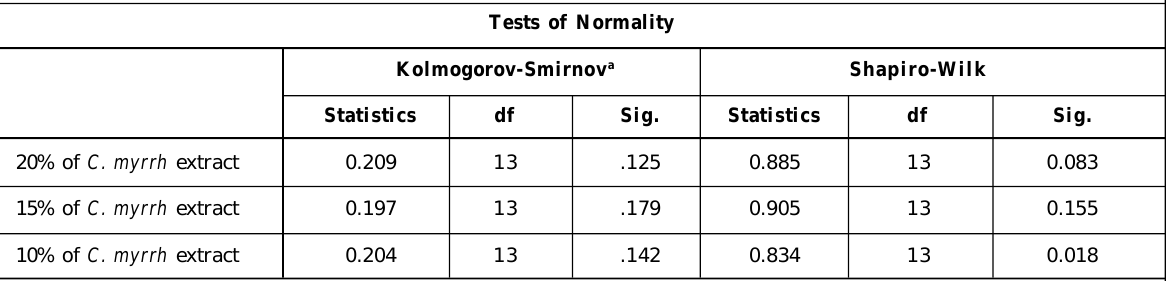
Table 3: Test the normality for three concentrations of C. myrrh extracts (20%/15%/10%) Tests of Normality Kolmogorov-Smirnov a